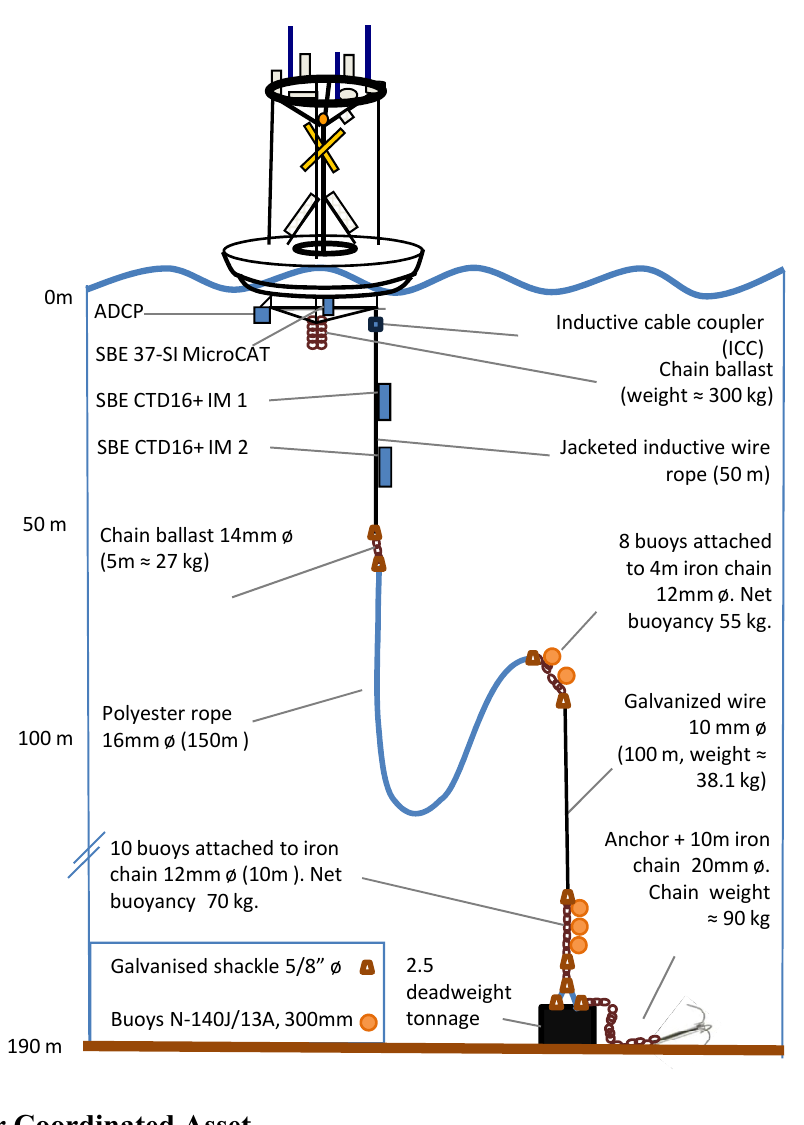
Figure 3. Inductive mooring configuration of the multisensory coordinated atmospheric and oceanographic